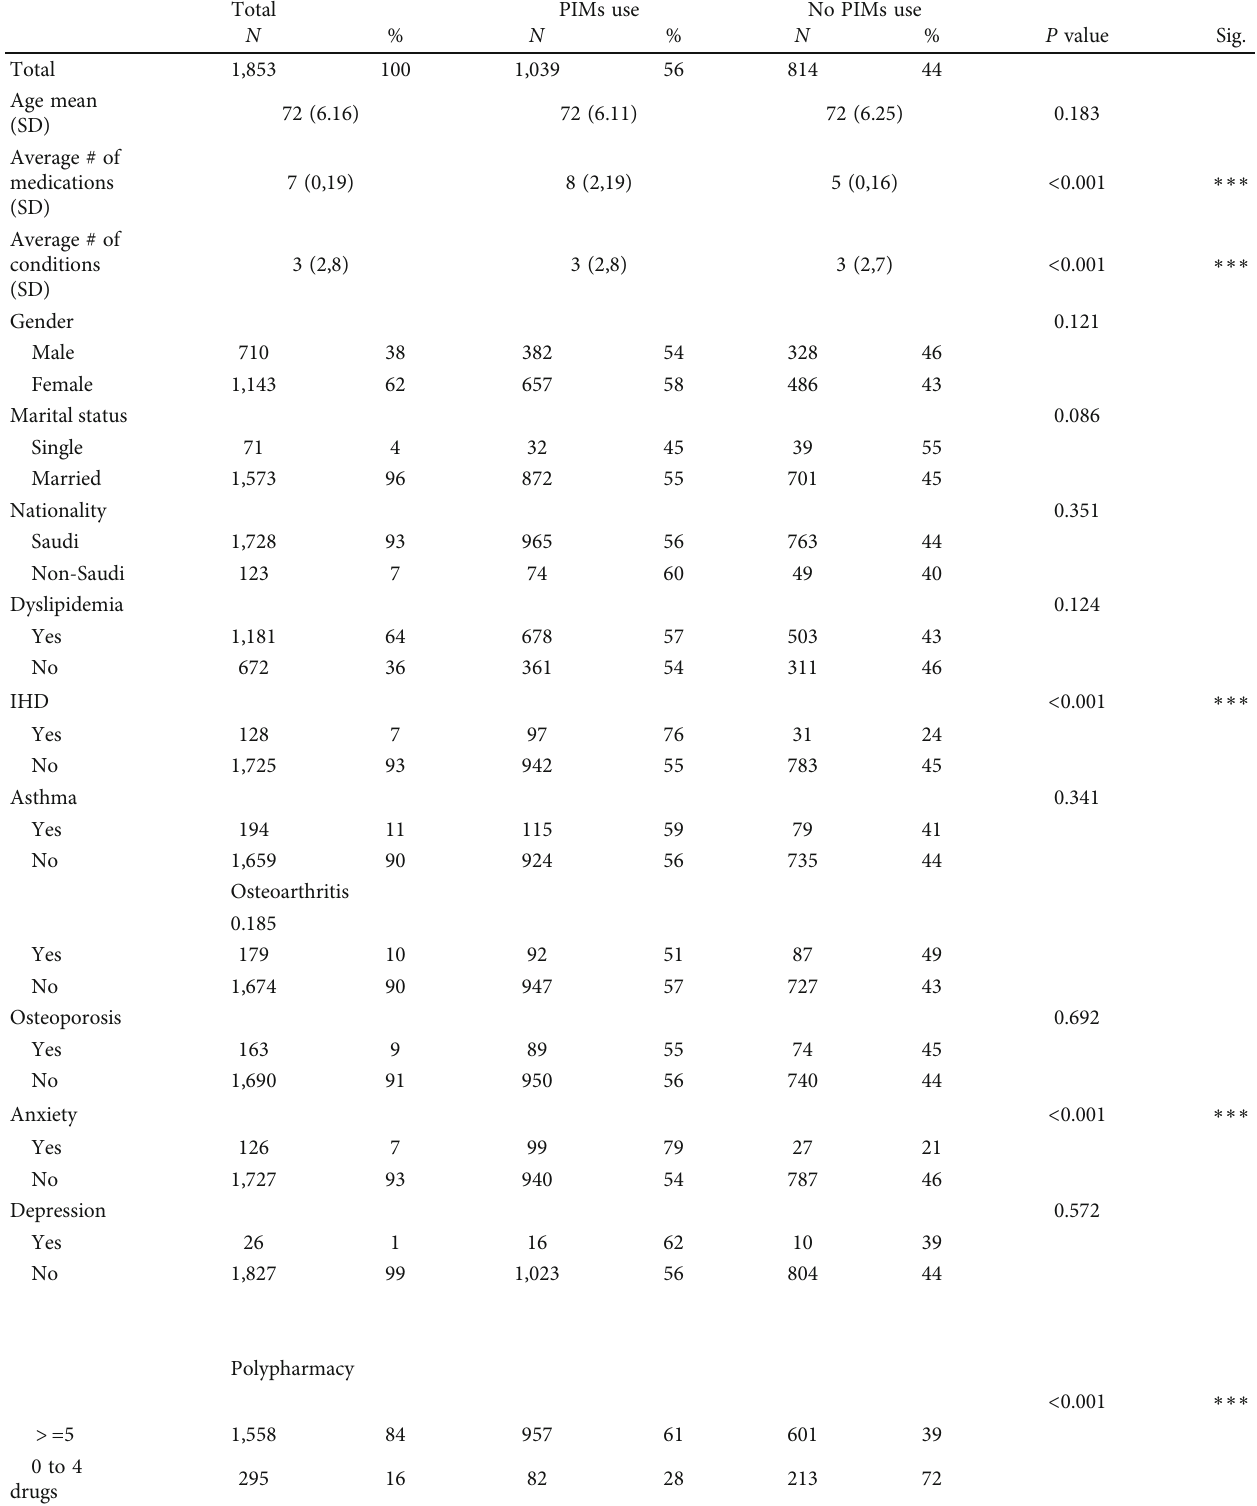
Table 1: Characteristics of the study population of older adults with comorbid diabetes and hypertension. Number and raw percentage of characteristics by potentially inappropriate medication